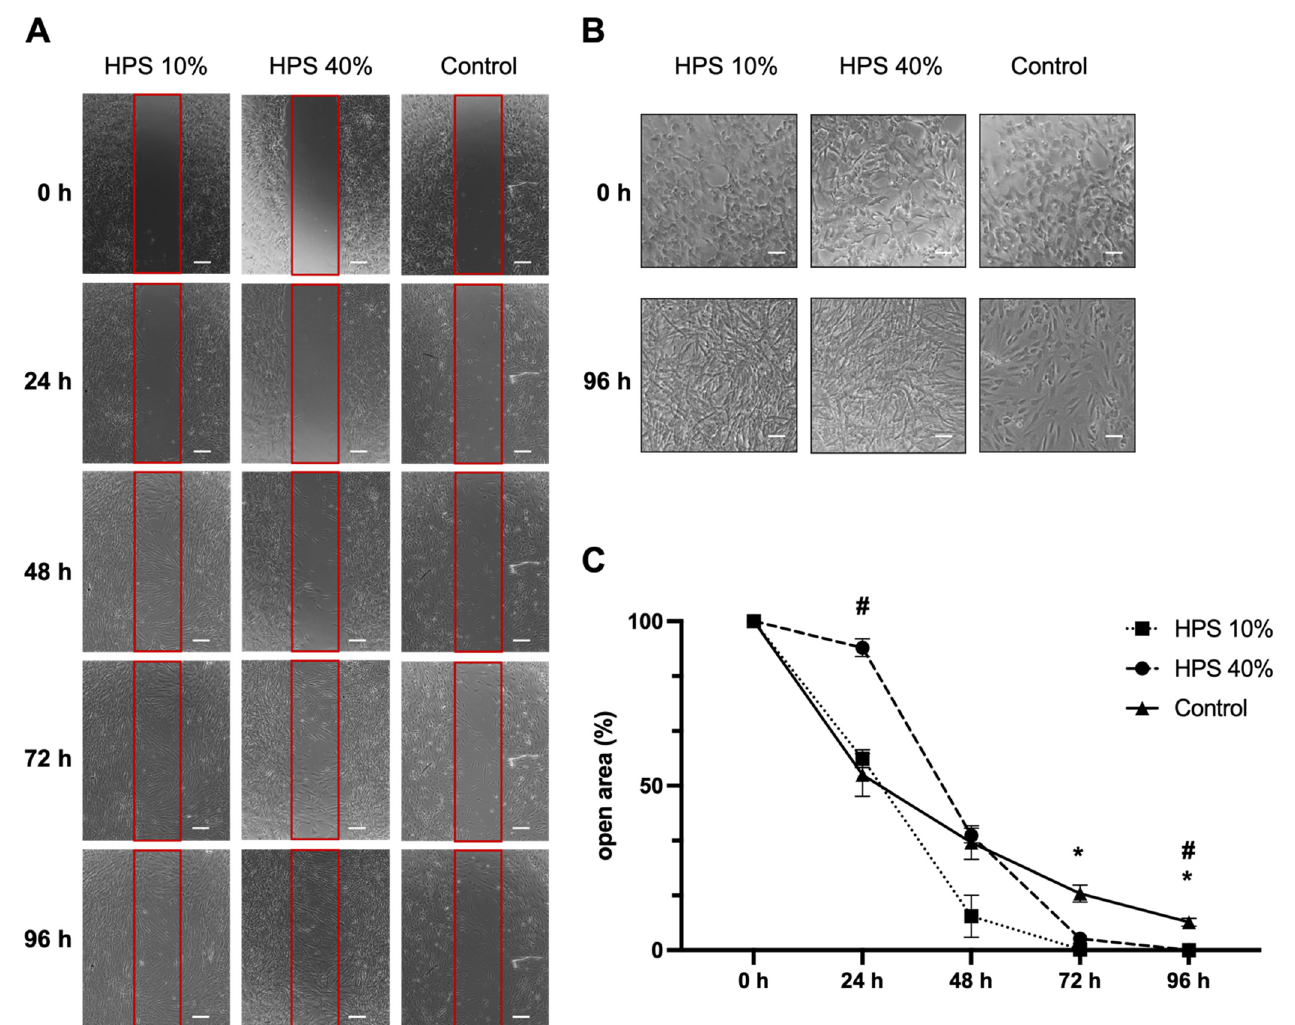
Figure 2 . Osteoblast migration is accelerated by hypoxia preconditioned serum (HPS) stimulation. ( A ) Representative microscopic photographs of scratch assay with human osteoblasts (n = 3) stimulated by HPS-10% and HPS-40% compared to controls taken at 24 h intervals over a 96 h period. Red boxes indicate the initially standardized open area. Scale bar = 200 µm. ( B ) Image panel showing two-fold magnifications in HPS-10%, HPS-40% and controls at 0 h and 96 h demonstrating changes of cell shape from cuboid to elongated osteoblasts in the HPS treated groups. Scale bar = 100 µm. ( C ) Plot showing closure of the open area (residual area in % of the full area) calculated by image analysis of the digital photographs depicted in (A). Asterisk (*) indicates statistical significance between HPS 10% and controls, hash (#) indicates statistical significance between HPS-40% and controls. Two-way repeated-measures ANOVA with Tukey’s multiple comparisons test. Data points are means ± SEM, n = 3. * p < 0.05; # p < 0.05.